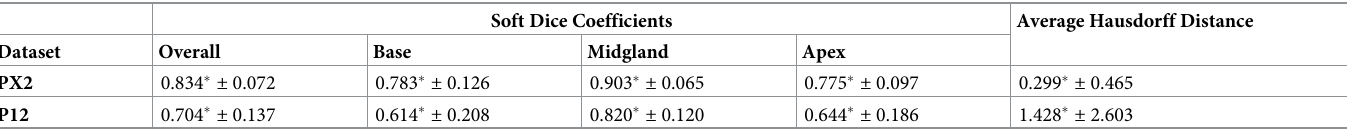
Table 4. Evaluation results for refined BraTS